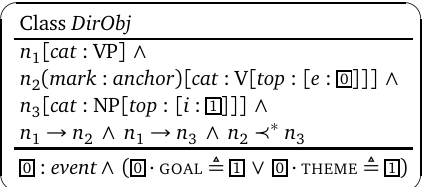
Tree and frame descriptions in